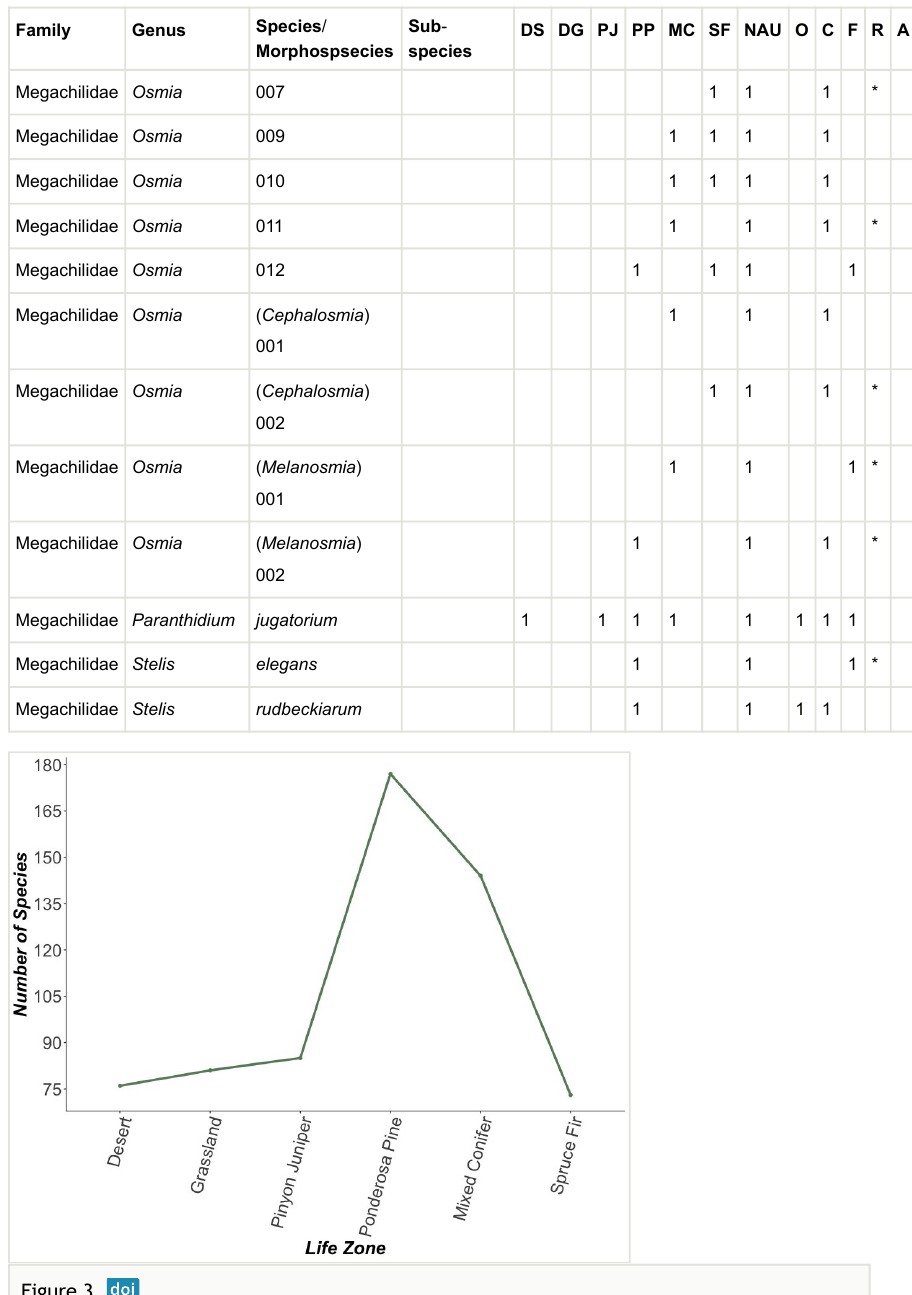
Figure 3. Number of bee species found at each life zone (n=339 species for which we had accurate locality data to assign life zone